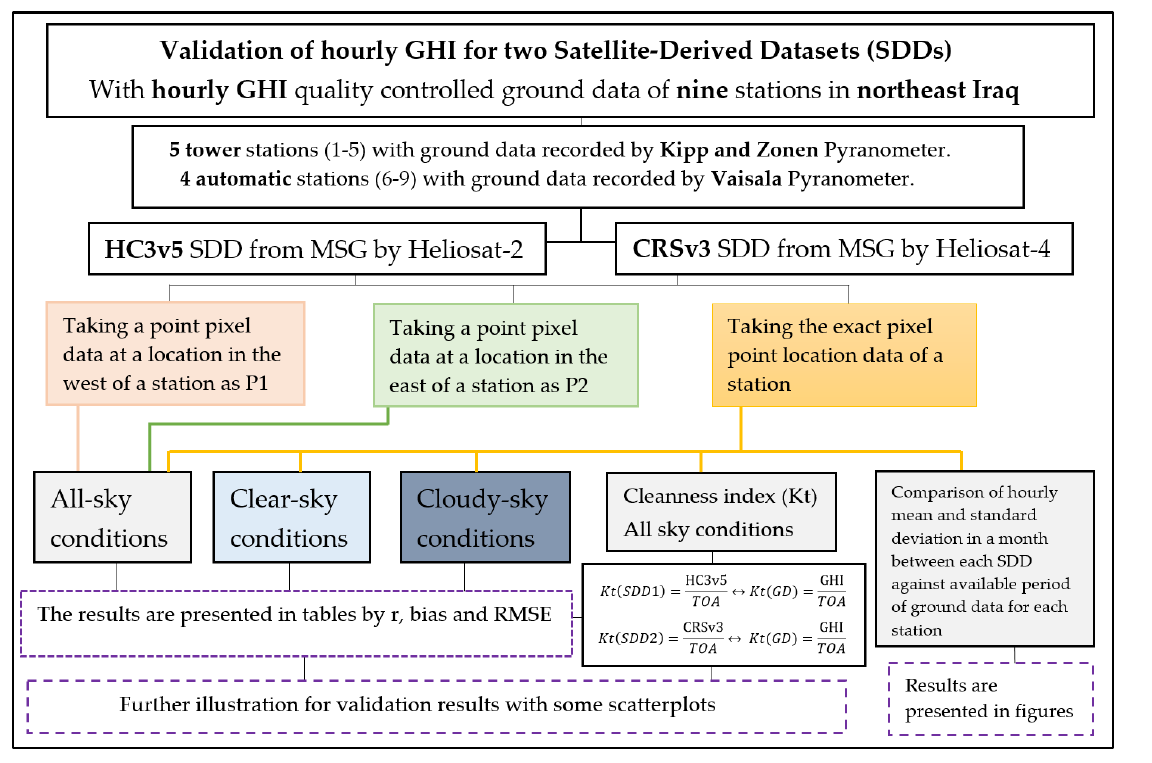
Figure 3. The flowchart of the approach.